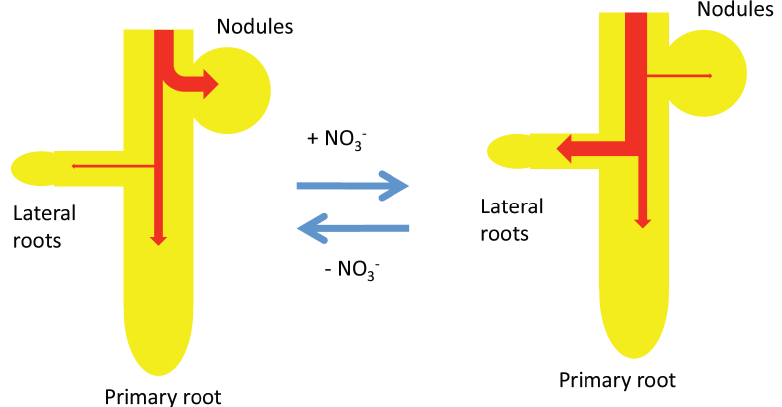
Figure 5. A model for the effects of nitrate on the growth of nodules, the primary root, and lateral